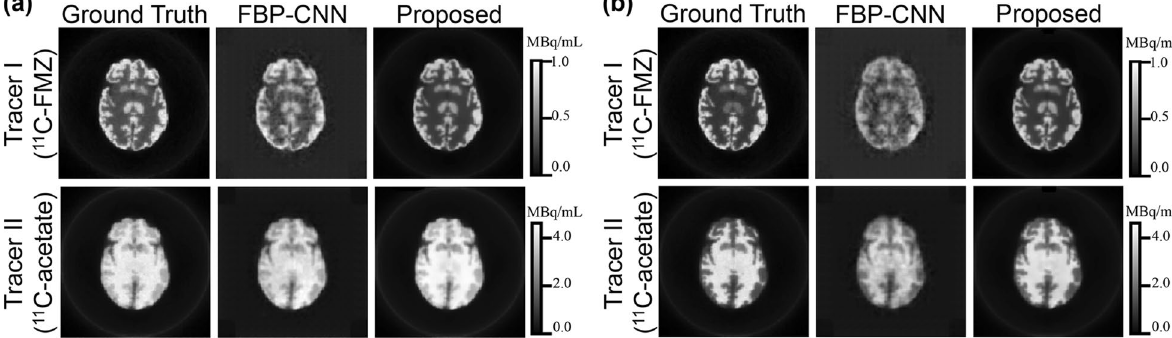
Fig. 3 The representative reconstructed images from the individual difference experiment. a 10% kinetic variation, b 20% kinetic variation. These images show the 10th frame of the dynamic